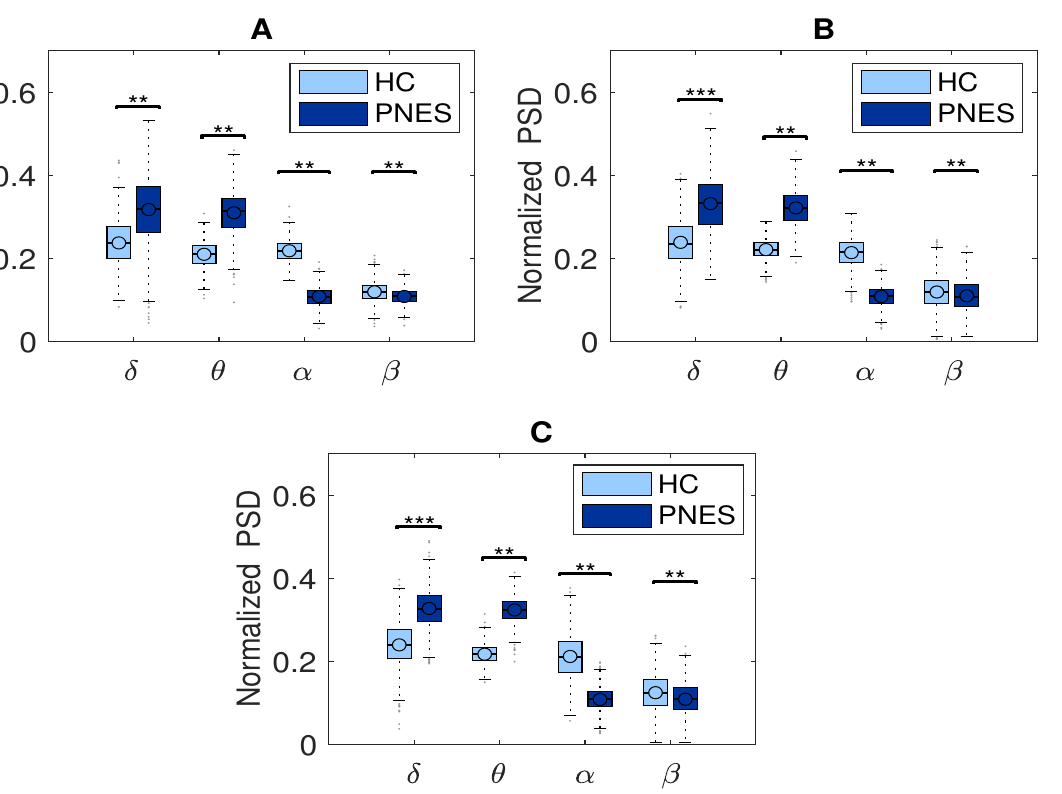
Figure 4. Relative normalized PSD, averaged over the 19 electrodes, in four frequency bands for frontal (see panel ( A )), central (see panel ( B )), parieto-occipital area (see panel ( C )) between PNES and the control group. The horizontal mark within each box represents the median, the edges of the box represent the first and third quartile. The horizontal line denotes significant difference between groups, where ** stand for p < 0.05, and *** for p < 0.001. The PSD measures was computed in PNES and control in the delta, theta, alpha, and beta frequency